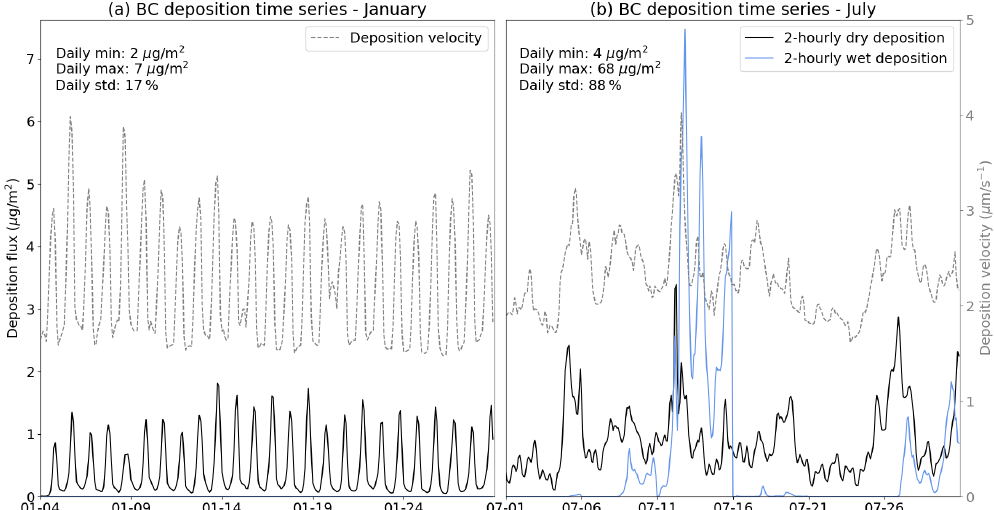
Figure 4. Time series of dry (solid black line) and wet (solid blue line) deposition flux and deposition velocity (dashed gray line) in (a) January and (b) July. Average over glacier-containing grid points within the area considered in Fig. 3.